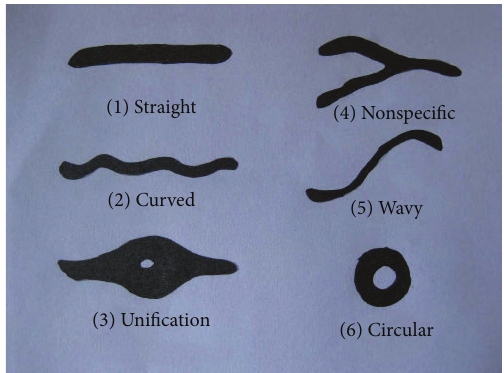
Figure 3: Line diagrams showing various patterns of palatal rugae in humans.